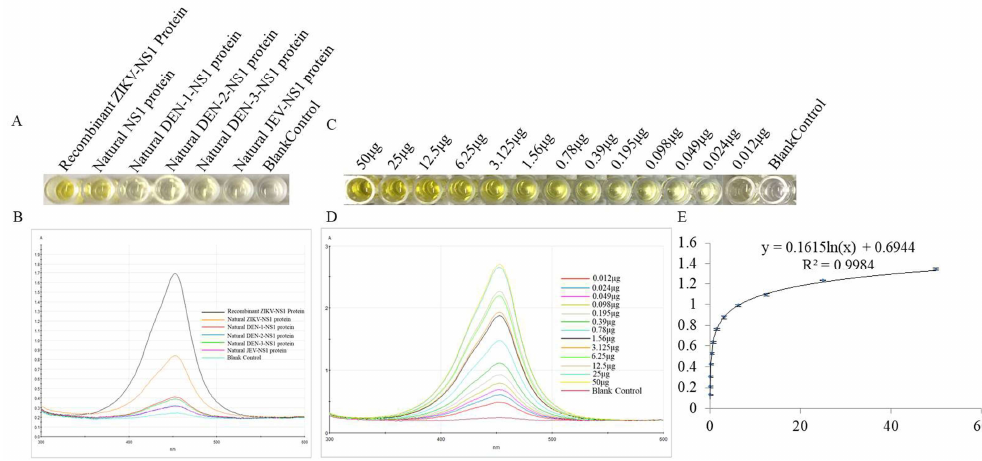
Figure 5. Specificity and sensitivity of the DAS-ELISA. ( A ) Specificity of the DAS-ELISA: well 1 represents the recombinant ZIKV-NS1 protein; well 2 represents the natural NS1 protein in the cell culture supernatant that infected with ZIKV; well 3 − 6 represent the natural NS1 protein in the cell culture supernatant infected with DEN-1, DEN-2, DEN-3, and JEV, respectively; and well 7 represents the blank control. ( B ) Optical density for the detection of different viruses. ( C ) Sensitivity of the DAS-ELISA: well 1 − 13 represent the different concentrations of recombinant ZIKV-NS1 proteins (500 µ g mL − 1 –0.122 µ g mL − 1 ), well 14 represents the blank control. ( D ) Optical density for the detection of different concentrations of recombinant ZIKV-NS1 protein (500 µ g mL − 1 –0.122 µ g mL − 1 ). ( E ) The plotted linear curve based on the different concentrations of recombinant ZIKV-NS1